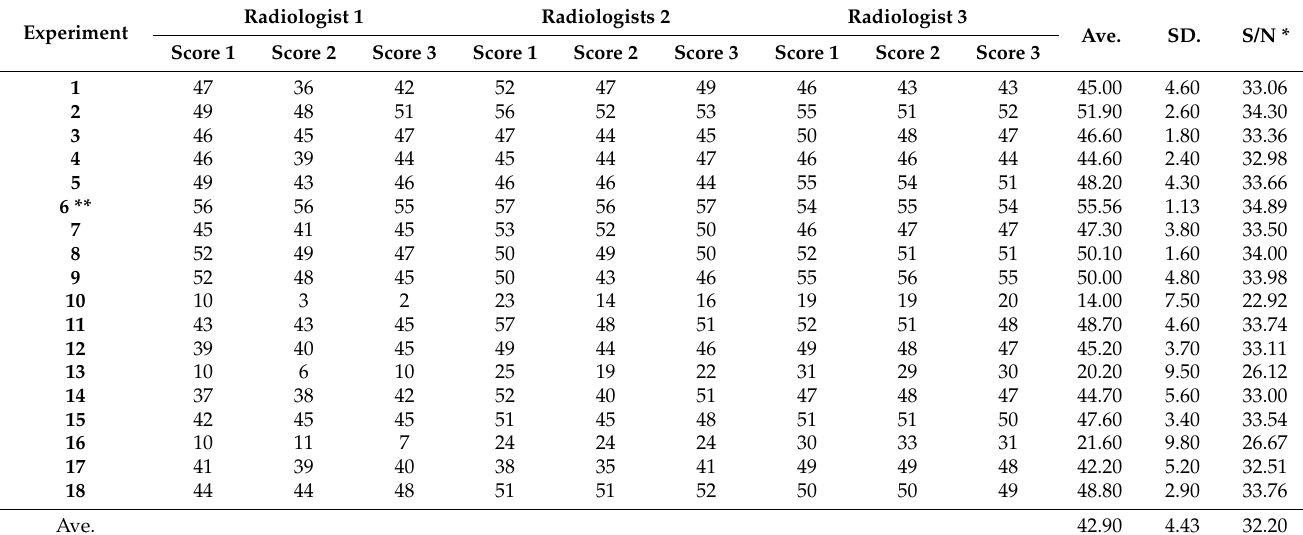
Table 3. Grading images from 18 experiments based on the Taguchi design.